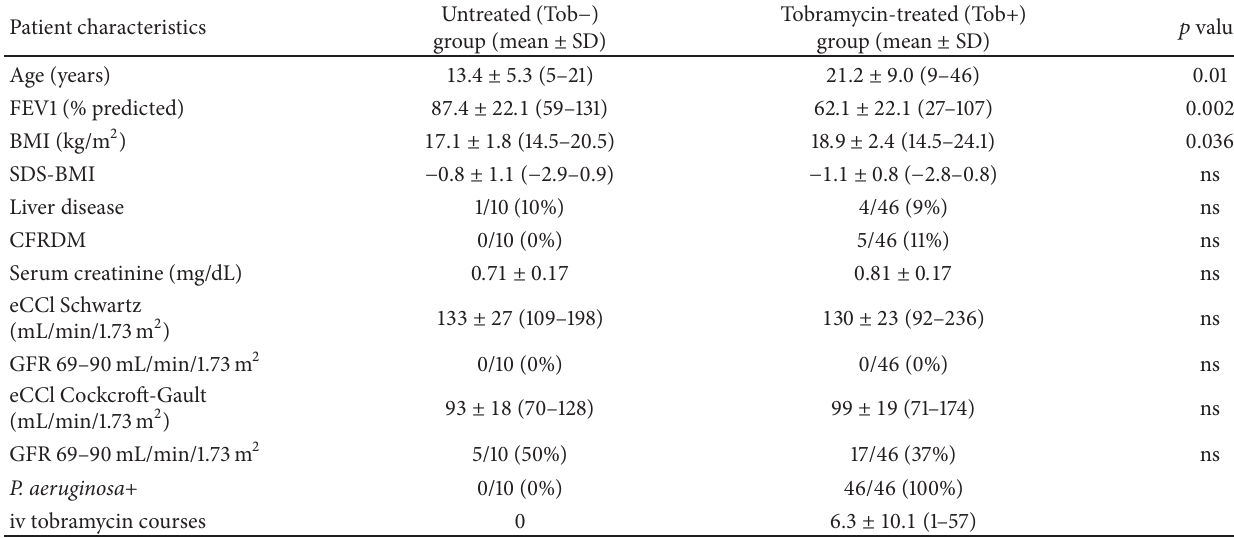
Table 1: Patient characteristics.